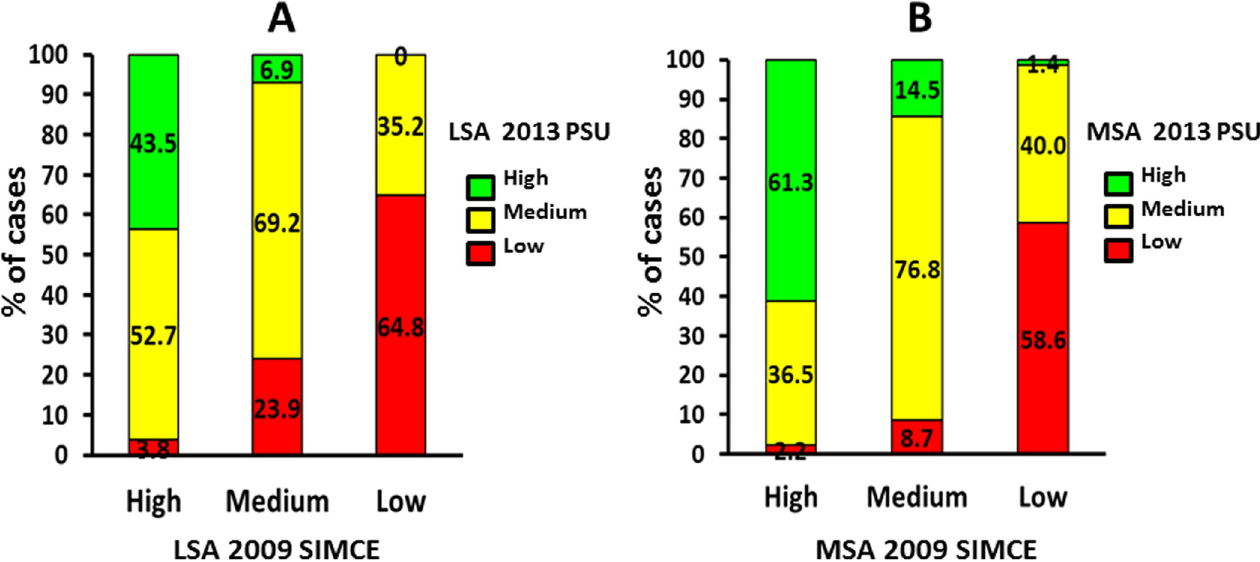
Fig 6. Association between the 2009 Quality Education Measurement System (2009 SIMCE) test of school-age children of the 2010 1HSG, four years later, with the 2013 University Selection Test (2013 PSU) outcomes, for university admission, when they graduated from high school, both language (LSA) (A) and mathematics (MSA) (B). Note. LSA: ( X 2 o (4df) = 195.763 > X 2 t (4df) p < .001 = 18.465). MSA: ( X 2 o (4df) = 291.332 > X 2 t (4df) p < .001 = 18.465).